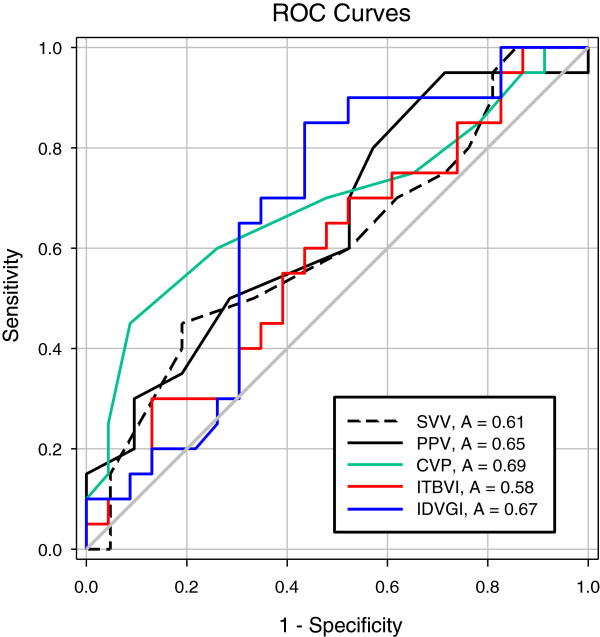
Receiver-operating characteristic (ROC) curves comparing the ability of various preload variables to discriminate responders and non-responders. CVP, Central venous pressure; IDVGI, Indexed initial distribution volume of glucose; ITBVI, Indexed intrathoracic blood volume; PPV, Pulse pressure variation; SVV, Stroke volume variation.